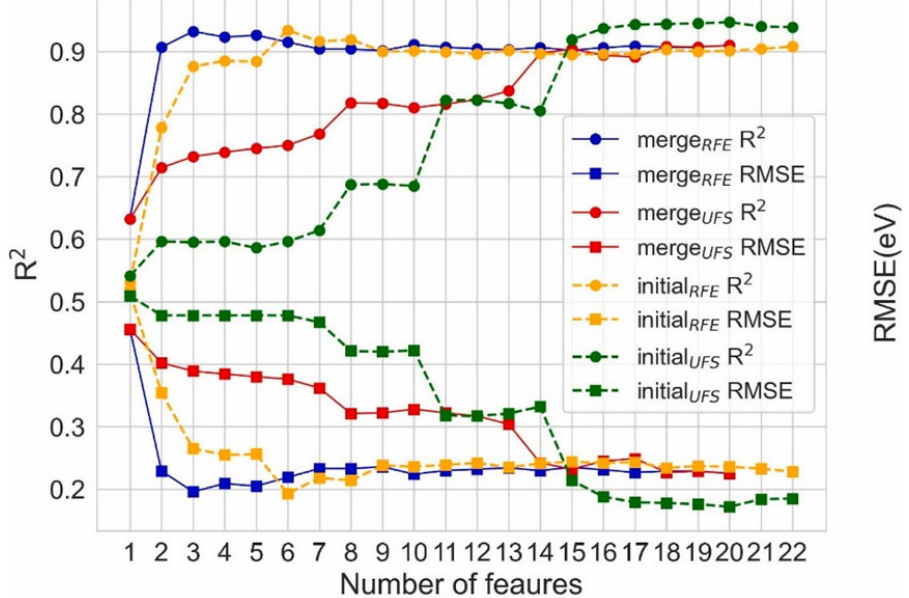
Figure 6. Computed test set RMSE and R 2 with n-dimension features, with n ranging from 1 to 22 for initial features but from 1 to 20 for merge features. Reprinted with permission from ref. [101]. Copyright 2022 Elsevier.